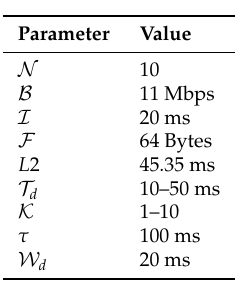
Table 15. Parameter